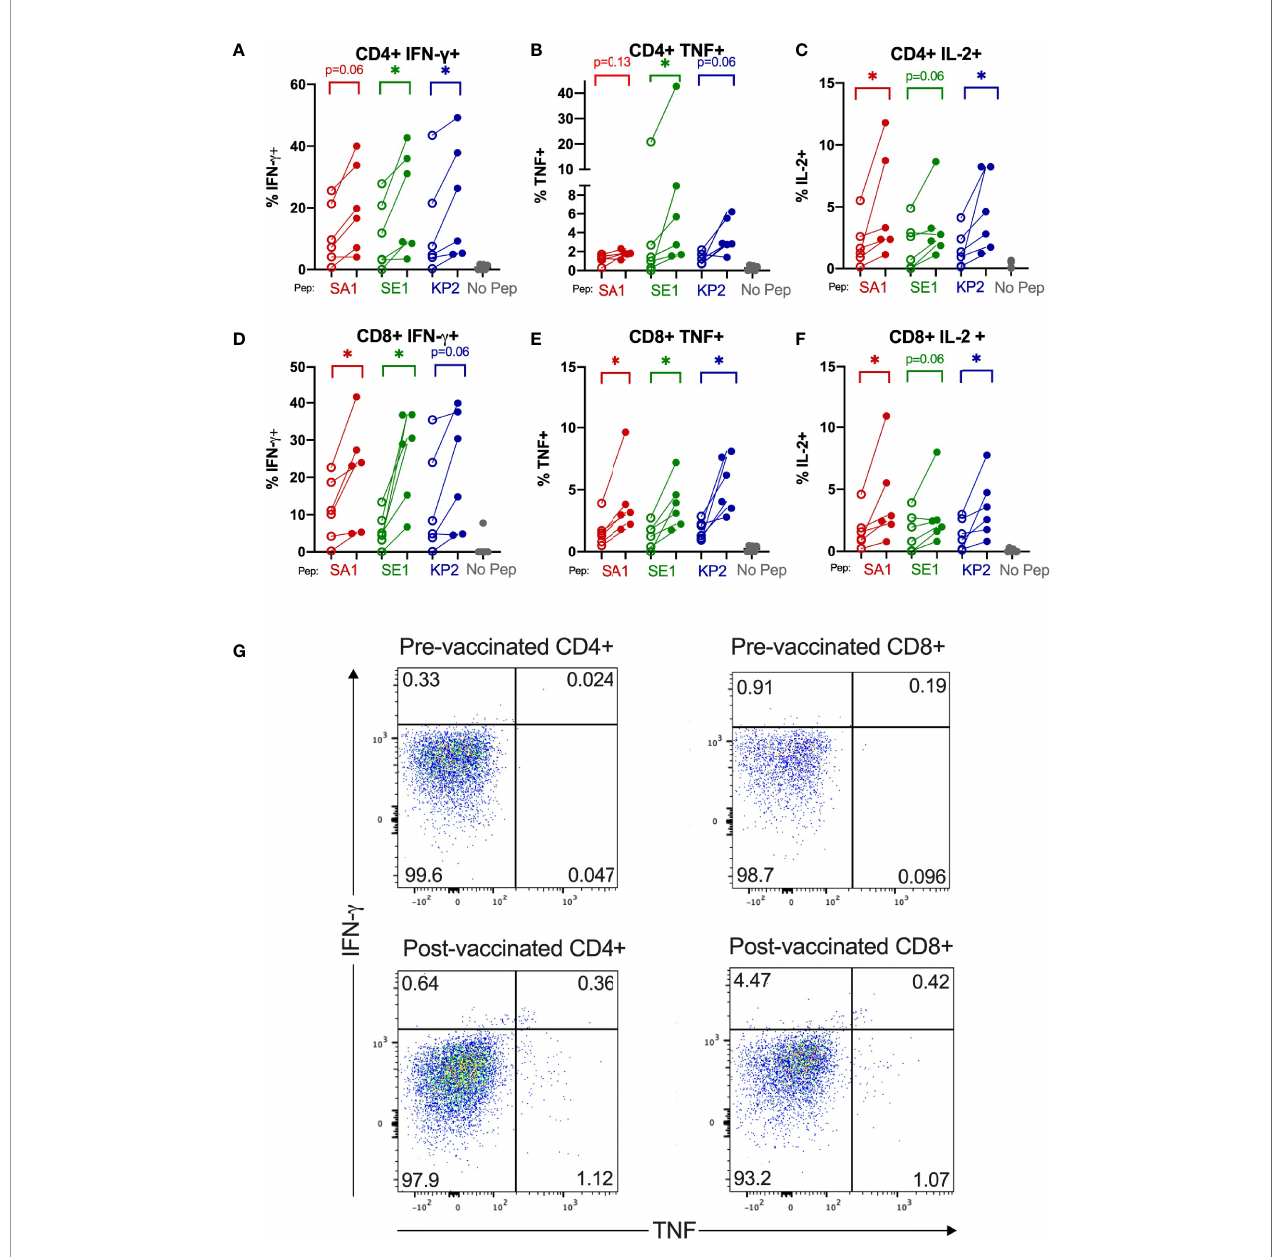
FIGURE 5 | SARS-CoV-2 vaccination enhances T cell cytokine reactivity to pathogenic bacterial homologues. Direct ex-vivo T cell responses of donors (n=6) pre- SARS-CoV-2 vaccination (unshaded dots) and post-SARS-CoV-2 vaccination (shaded dots) to pathogenic bacterial peptides sharing homology with SARS-CoV-2 spike (SA1, SE1 and KP2) measured by intracellular cytokine staining. No Pep – no peptide negative control. *P<0.05 by Wilcoxon matched-pairs signed rank test. (A) CD4 + IFN- g + responses (n= 6). (B) CD4 + TNF + responses (n= 5-6). (C) CD4 + IL-2 + responses (n= 6). (D) CD8 + IFN- g + responses (n= 6). (E) CD8 + TNF + responses (n= 6). (F) CD8 + IL-2 + responses (n= 6). (G) Representative donor T cell TNF (x-axis) and IFN- g (y-axis) dot plots of pre-vaccinated CD4 + and CD8 + (top) and post- vaccinated CD4+ and CD8+ (bottom) responses to bacterial peptide